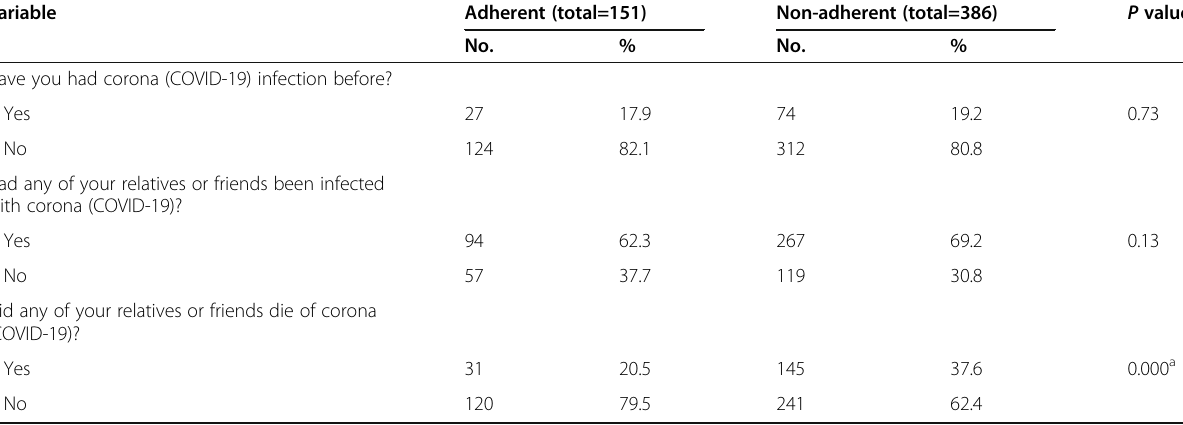
Table 5 Infections and deaths of COVID-19 and the adherence status of male students at Al-Azhar Faculty of Medicine, Cairo,